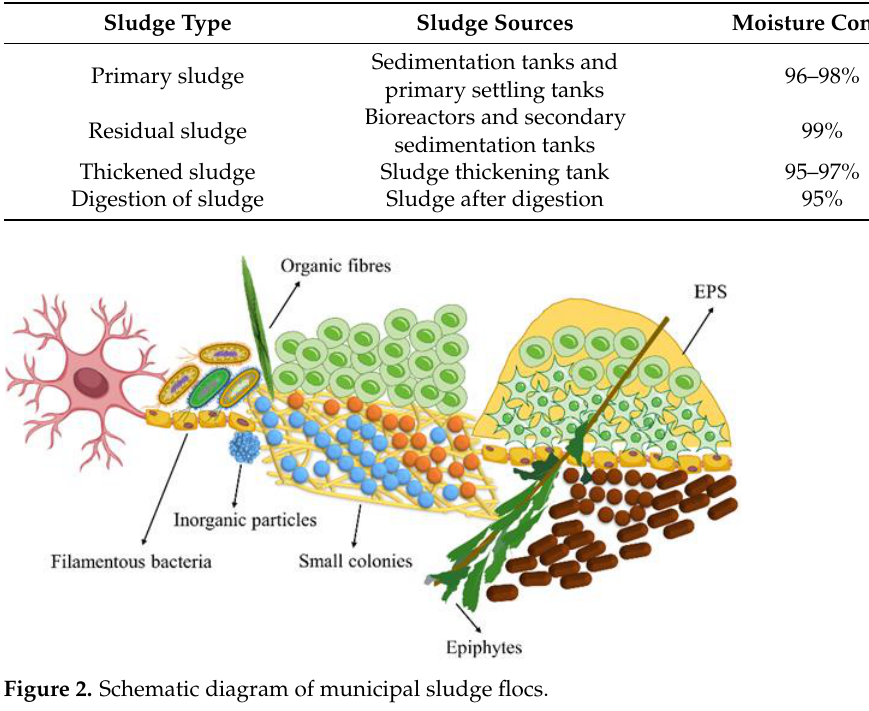
Table 2. Classification of municipal sludge.